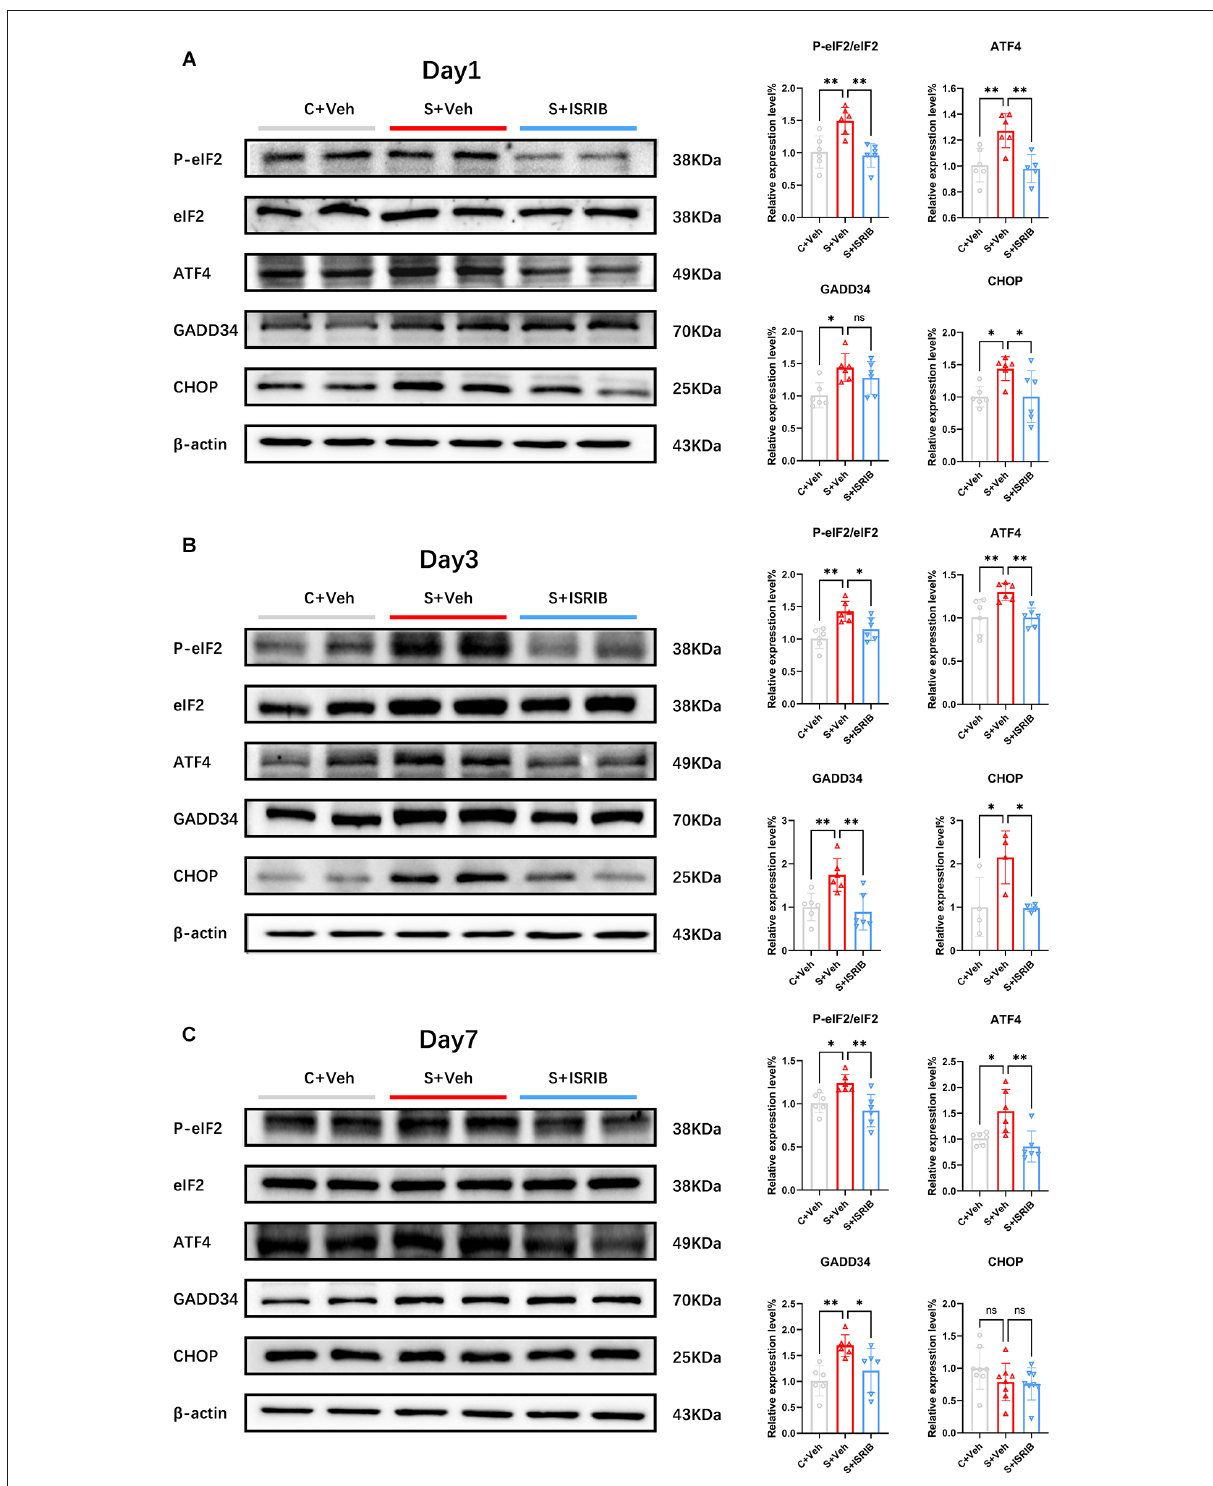
FIGURE2 POCD induced eIF2 α phosphorylation and related protein changes in the hippocampus of mice and therapy with ISRIB attenuated the changes. (A–C) Changes in PeIF2, eIF2, ATF4, GADD34, and CHOP protein expression on post-surgery days 1 (A) , 3 (B) , and 7 (C) in all groups. Relative protein expression is expressed as the ratio of the target protein to β -actin. Representative protein bands are shown on the left and quantification are shown on the right. Data are presented as the mean ± SEM. One-way ANOVA was used for statistical analysis. ∗ p < 0.05; ∗∗ p < 0.01; ns: no statistical